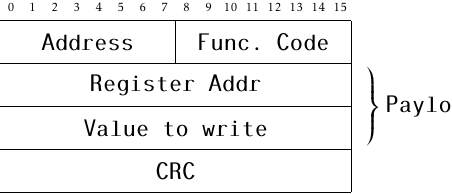
Figure 6. Example of a Modbus frame with a payload containing messages between MTU and RTU.